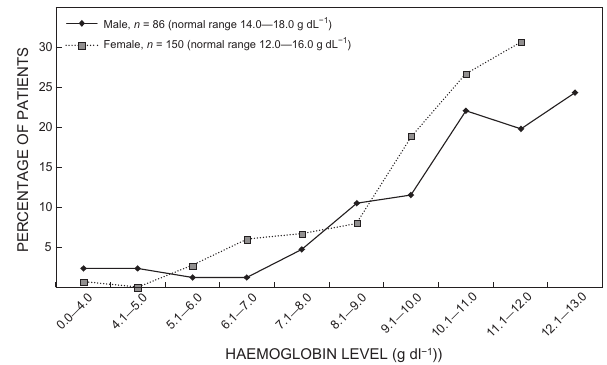
Figure 2: Distribution of haemoglobin levels of hospitalised geriatric patients with anaemia ( n = 236)